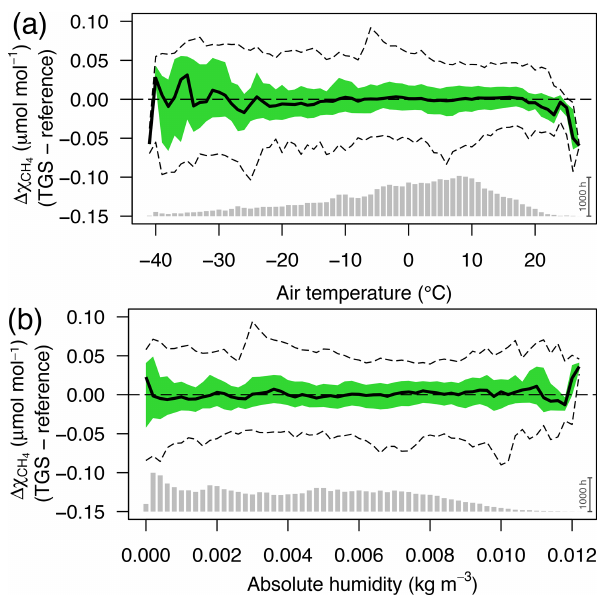
Figure 12. Residuals of 30min averaged TGS 2600 vs. refer- ence CH 4 measurements as a function of (a) air temperature and (b) absolute humidity. Colored areas show the interquartile range (50% CI), bold lines show the median, and dashed lines show the bin-averaged 95% confidence interval. Bin size was 1 ◦ C and 0.0002kgm − 3 , respectively. Gray bars at the bottom show the num- ber of 30min averages in each bin; the scale bar (1000h) on the right specifies their